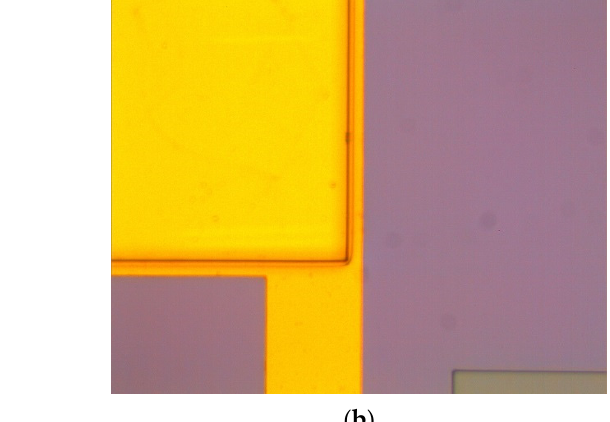
( b ) Figure 6. Image of the metallic contacts for the ( a ) reference MOS-FET ( b ) color-coded. Then, the Ti film was deposited above through a correspondent mask, followed by TiO 2 conversion in nanostructured-TiO 2 . 3.2. Results for Nanostructured TiO 2 The samples were characterized by spectrometer FTIR and SEM tools. The best re- sults for the anodizing process were achieved for a potential of 5–10 V, keeping the pH in a range of 6.5–7.3 and preferably slightly acidic. The amount of water in the electrolyte must be high enough to obtain a good dispersion of NH 4 F salt in the cations and anions. The maximum limit of the partial concentration occurred for a saturated solution of NH 4 F/H 2 O 40%. The nanostructured TiO 2 film at a temperature of 450 °C was the anatase structure, while, at 800 °C, it became rutile. The SEM image of the TiO 2 film obtained by optimal anodizing and treated at a temperature of 450 °C in nitrogen atmosphere was visible in a lateral section for the an- atase form of nanostructured TiO 2 (Figure 7a).